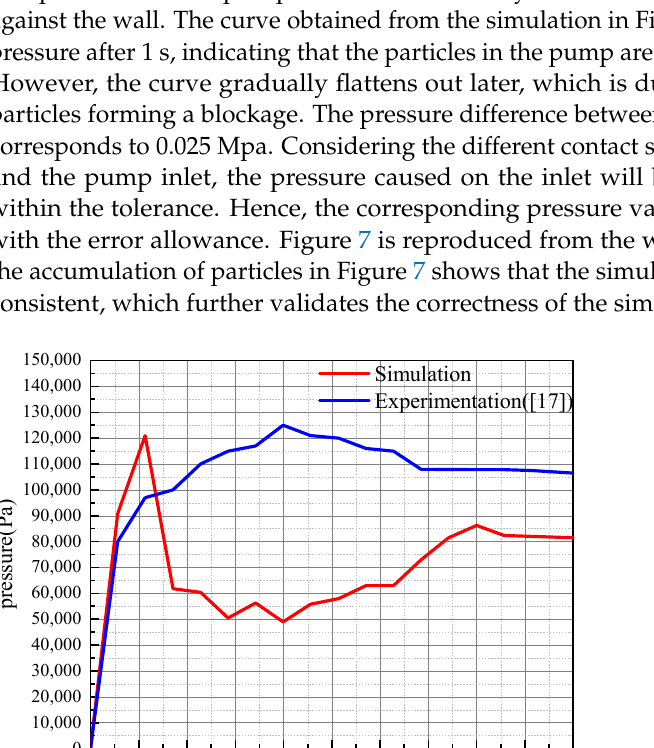
( b ) Figure 7. Particle reflux experimental and simulation comparison: ( a ) 40–50 mm particle reflux experimental; ( b ) simulation of 40–50 mm particle reflux. 4. Simulation Results Four groups of mixed particles with different particle size distributions (10–20 mm, 20–30 mm, 30–40 mm, 40–50 mm) were set up in this paper, and the blockage mechanism of the four groups of mixed particles was simulated numerically. For example, the particle size interval is 2 mm for 10–20 mm, which means that this group contains particles with particle sizes of 10, 12, 14, 16, 18, and 20 mm at concentrations of 75%, 5%, 5%, 5%, 5%, and 5%, respectively. The other groups are similar. The simulated clouds of pressure on the guide vane after collision with 10–20 mm particles are shown in Figure 8. It is noticeable when comparing Figure 8a,b that although both high and low-pressure areas appear on the guide vanes, the high-pressure area is denser at 10 s than at 2 s. This indicates that the particles collide intensively with the guide vane at 10 s. At the same time, these areas are found in the upper half of the guide vane close to the impeller hub and in the lower half of the guide vane away from the hub. It has been revealed that when a particle moves through a fluid, under the influence of the viscosity of the fluid, a high-pressure zone will be created ahead of the direction of motion of the particle, while a low-pressure area will be formed at the end of the trajectory and on its sides. The high-pressure and low-pressure areas on the guide vane shown in the pictures prove that the particles have good movement, and stagnation or blockage occurs. As shown in Figure 8c, except for the remaining three guide vanes, where the pressure variation zone still exists at the end of the vanes, the rest of the vanes are no longer under pressure from the particles. This demonstrates that the pre-set particles have fallen entirely, and the majority of them have passed through the interface between the guide